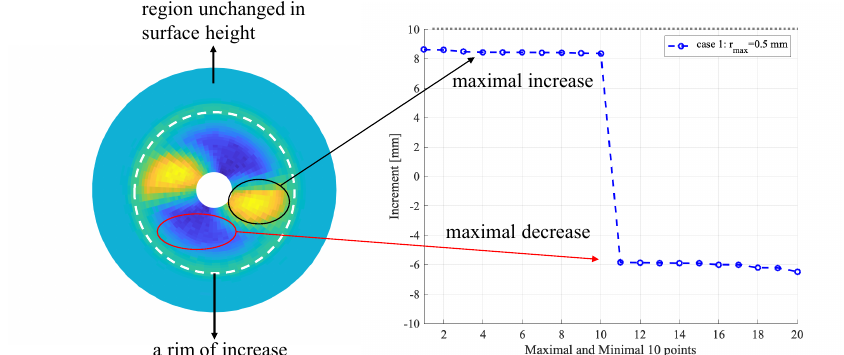
Figure 8. Measurement of the change in surface height in DEM simulation.